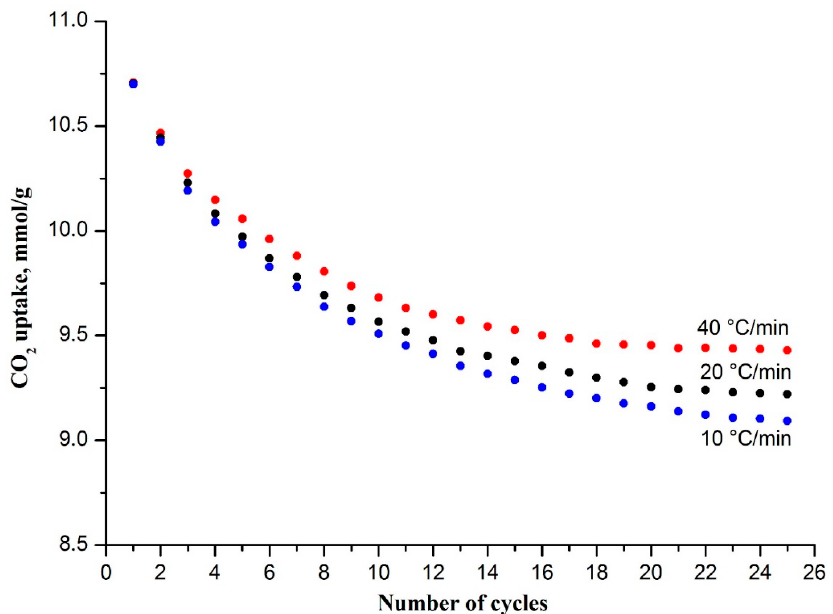
Figure 4. CO 2 uptake capacity evolution of the sorbent over cyclic carbonation–decarbonation at different heating rates. The carbonation is performed in the gas flow containing 15 vol.% CO 2 at 630 °C.